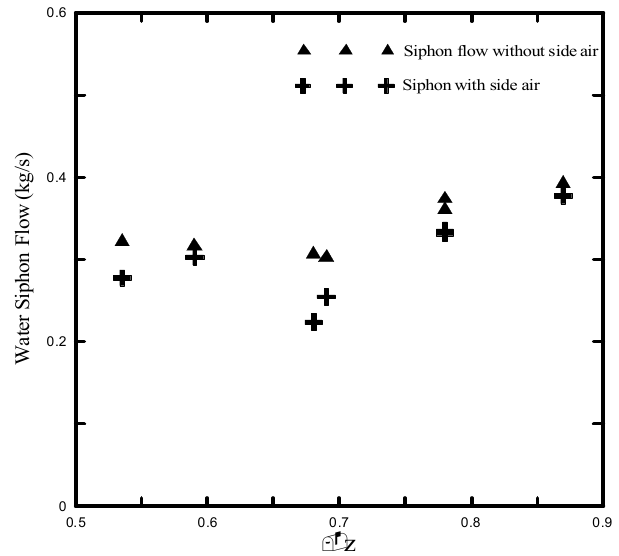
Figure 5. E ff ect of side air on the water siphon Figure 5. Effect of side air on the water siphon flow.